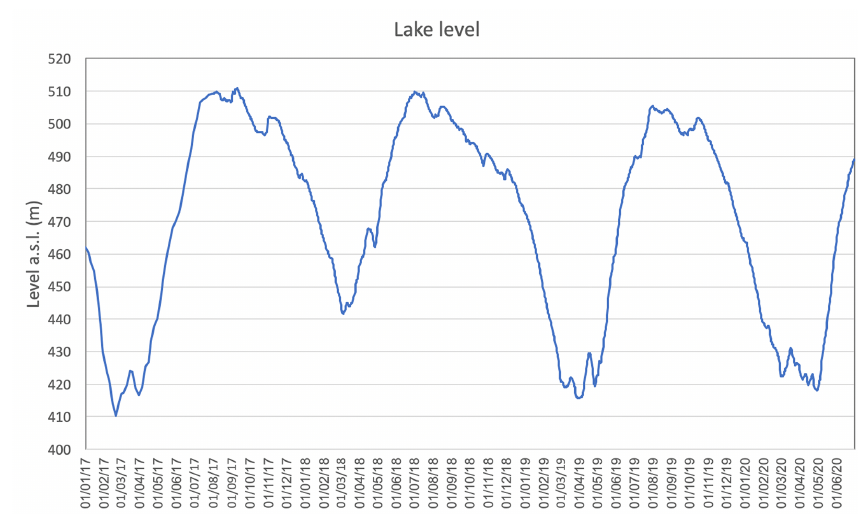
Earth Syst. Sci. Data, 13, 3321–3335, 2021